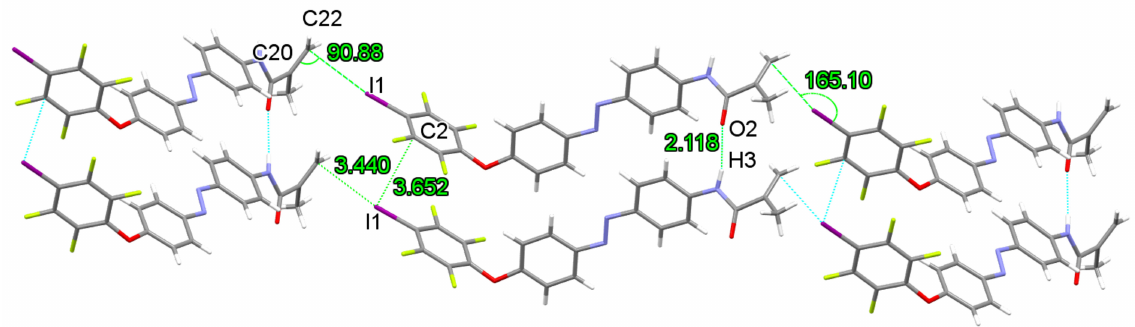
Figure 3. X-ray structure of I–azo–NH–MMA developing undulating parallel chains due to C ··· I halogen